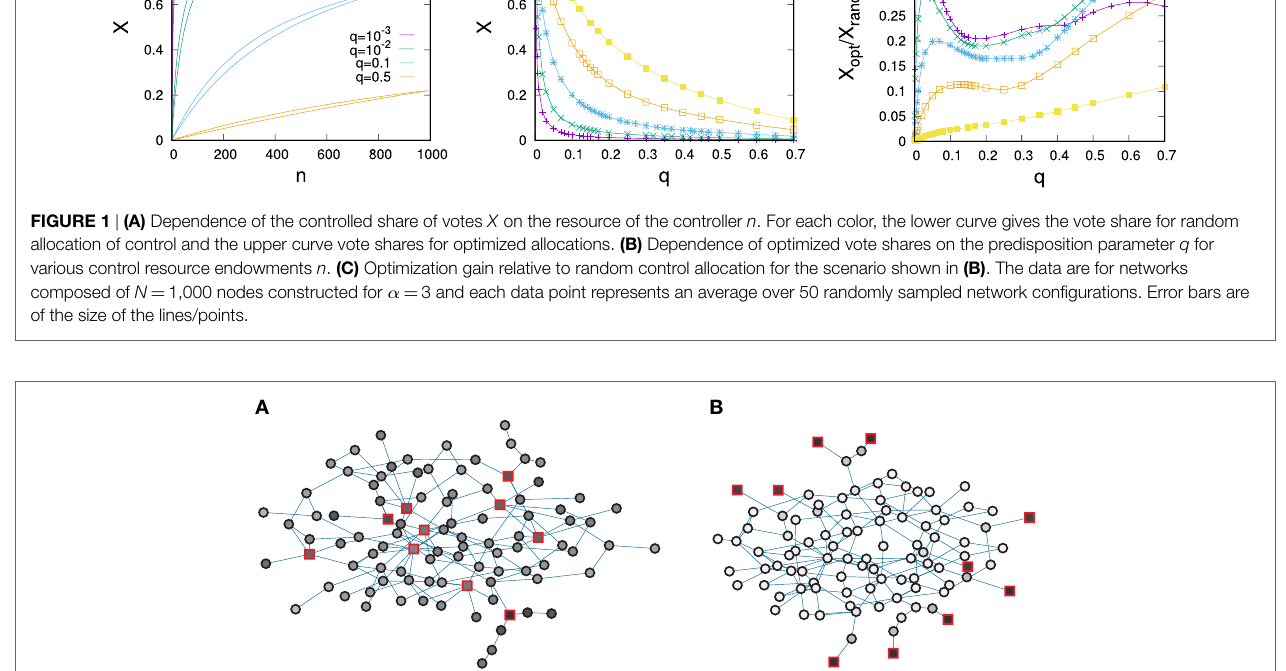
Frontiers in Robotics and AI |